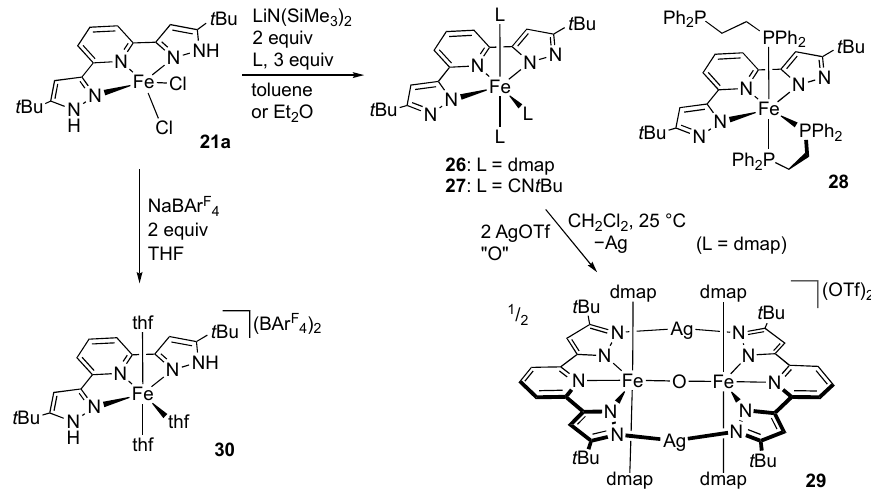
Scheme 9. Dehydrochlorination of the t Bu LH 2 iron complex 21a in the presence of donor ligands. dmap = 4-dimethylaminopyridine.